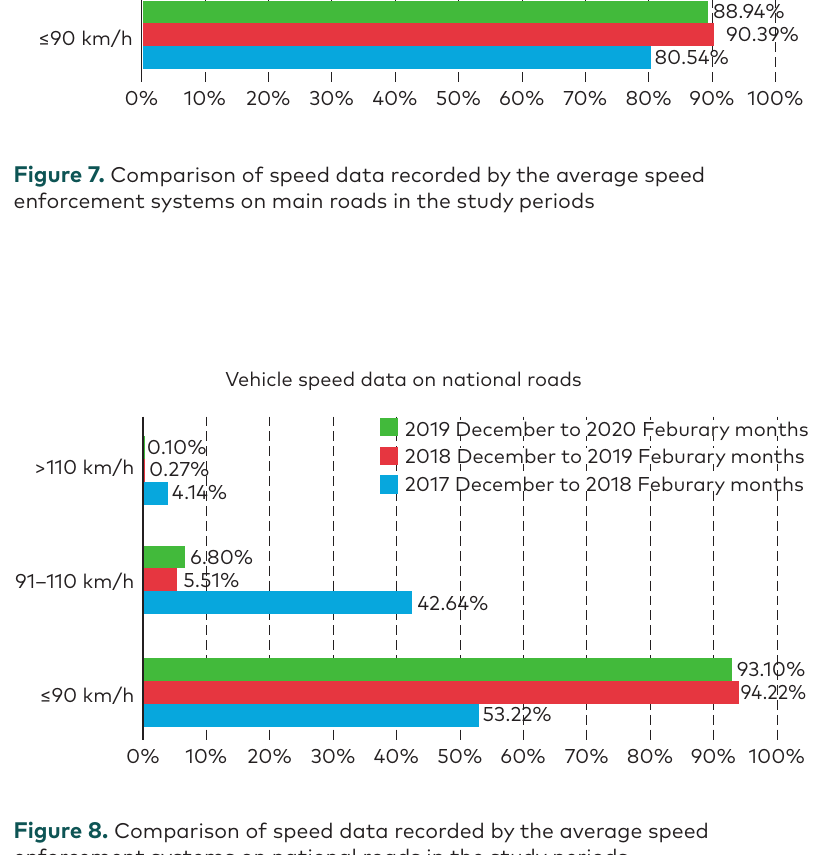
Figure 8. Comparison of speed data recorded by the average speed enforcement systems on national roads in the study periods